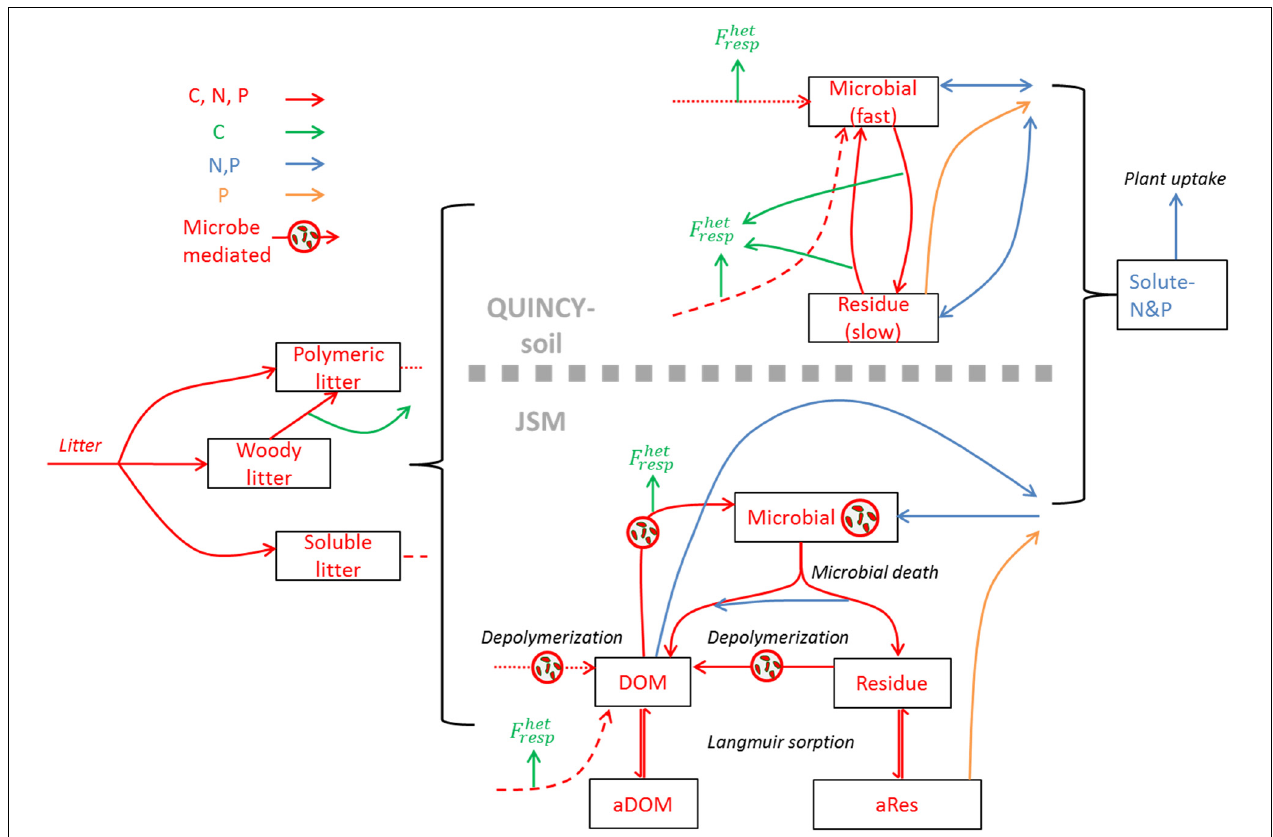
FIGURE 1 | Model structure comparison between QUINCY-soil and Jena Soil Model (JSM). The fast SOM pools in JSM include the Microbial, DOM, and Residue pools, and the slow SOM pools refer to the mineral-adsorbed DOM (aDOM) and residue (aRes) pools. The soil litter pool in both models refer to the woody, polymeric, and soluble litter; both models share the same litter distribution process, and the effluxes from polymeric and soluble litter are distinguished with dash line